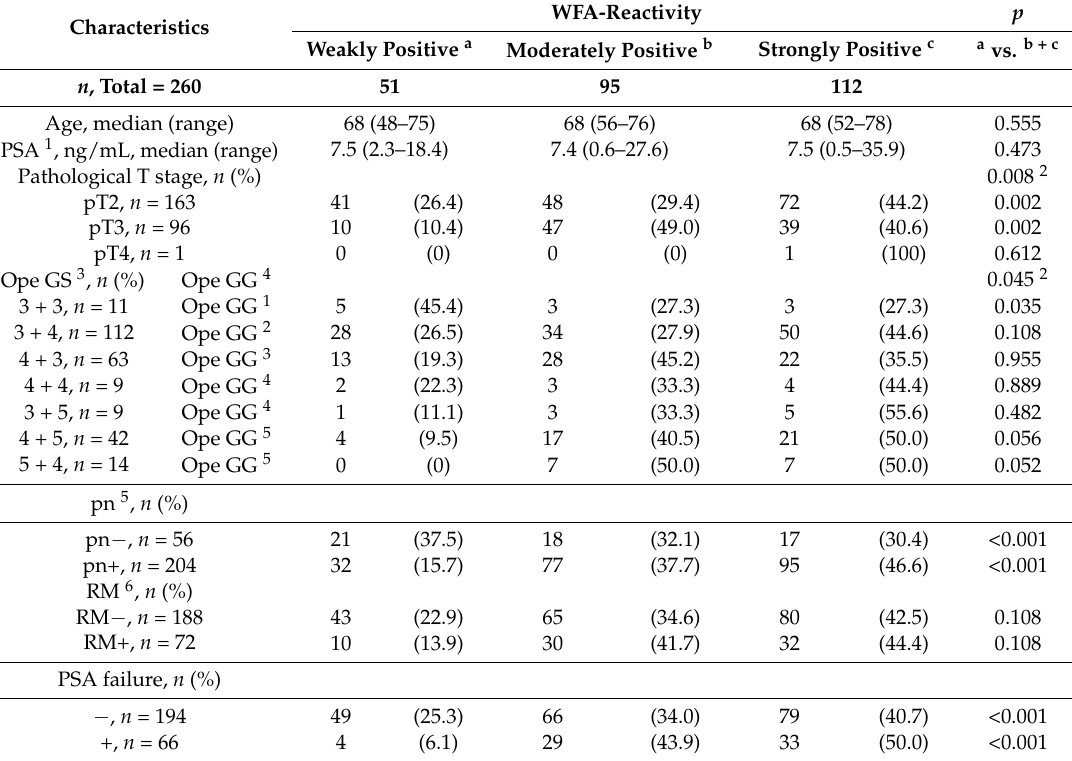
Table 3. Characteristics of PCa patients who underwent RP categorized by WFA-reactivity.